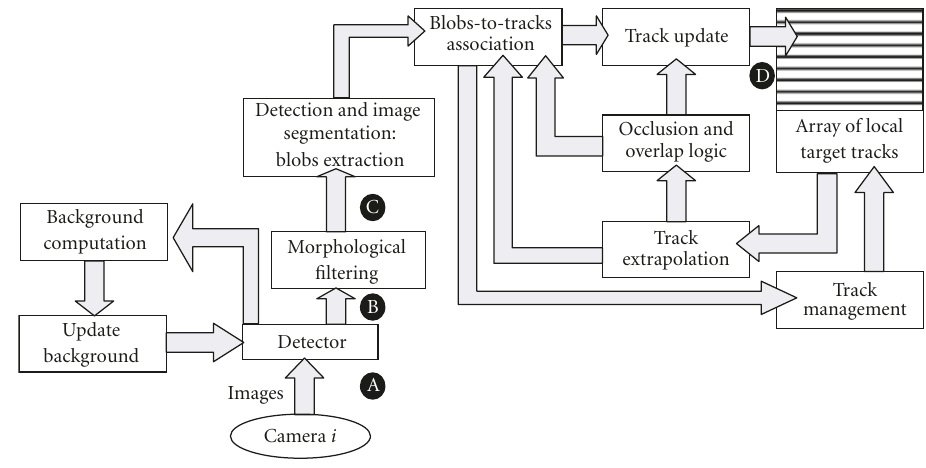
Figure 3: Structure of video surveillance